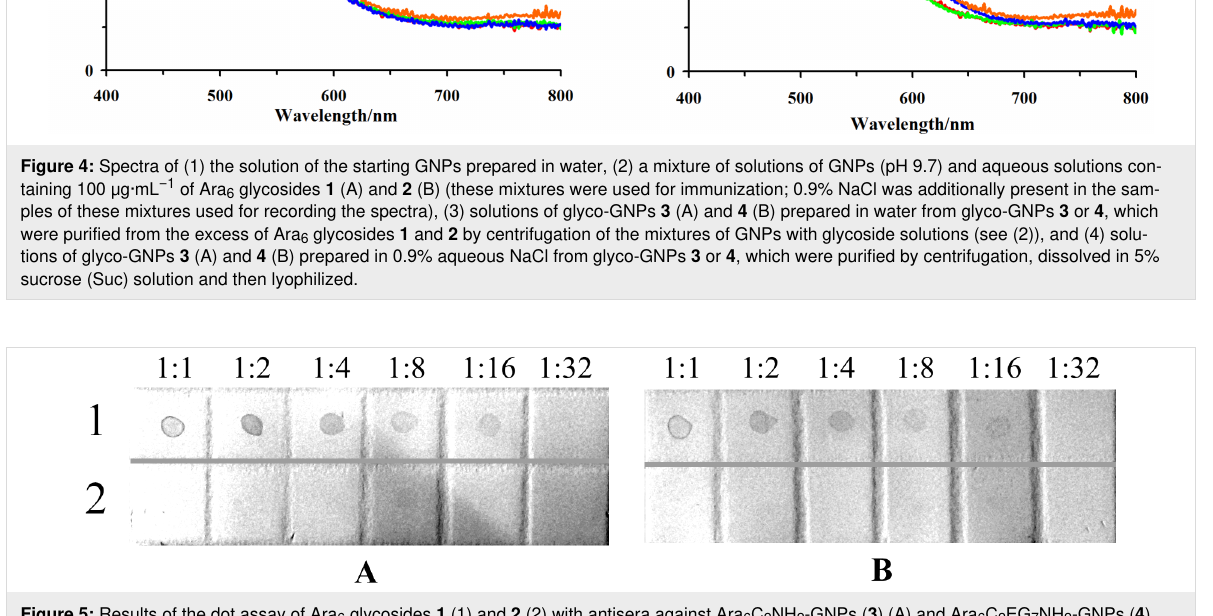
Figure 5: Results of the dot assay of Ara 6 glycosides 1 (1) and 2 (2) with antisera against Ara 6 C 2 NH 2 -GNPs ( 3 ) (A) and Ara 6 C 2 EG 7 NH 2 -GNPs ( 4 ) (B). Solutions of glycosides (1 mg·mL − 1 ) in H 2 O were titrated